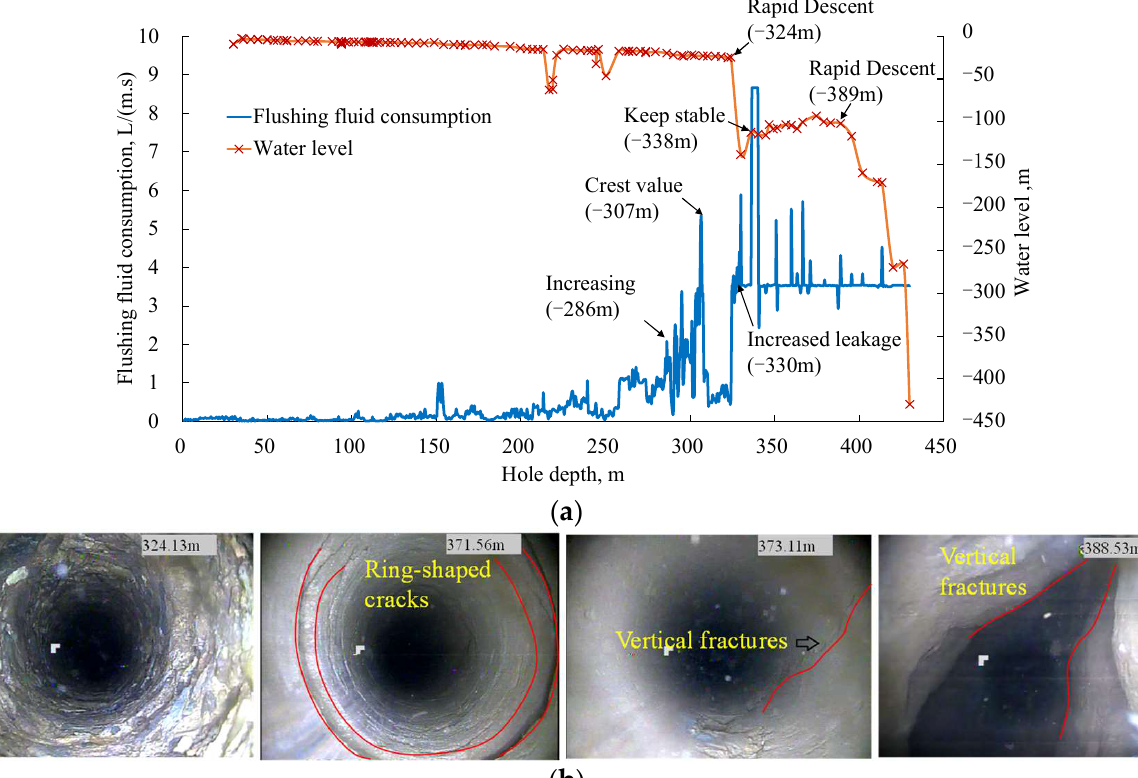
Figure 8. In situ detection result at No.Y1-1 borehole. ( a ) Flushing fluid and bore water level variation, and ( b ) borehole camera .